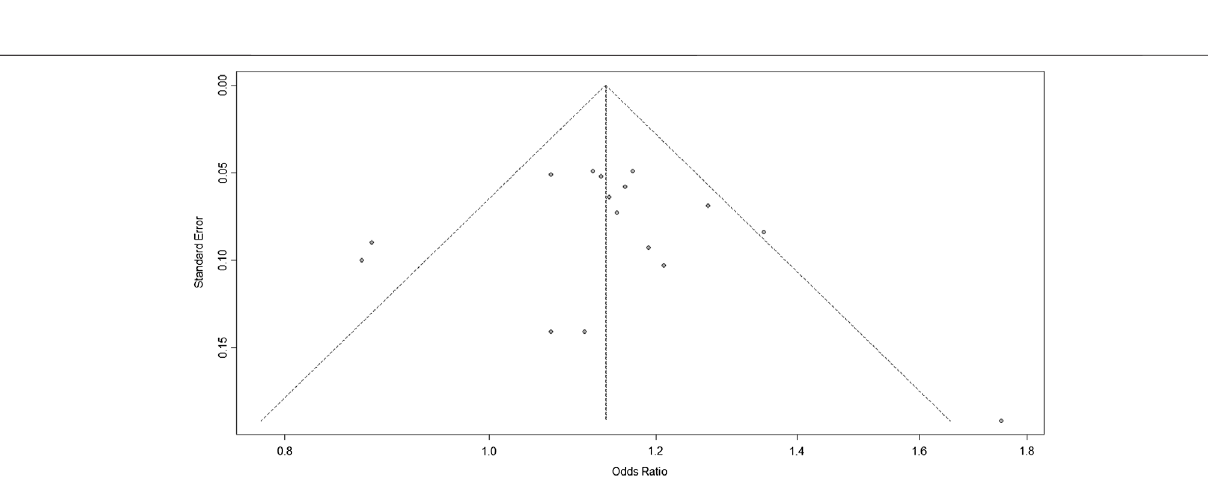
Frontiers in Genetics |